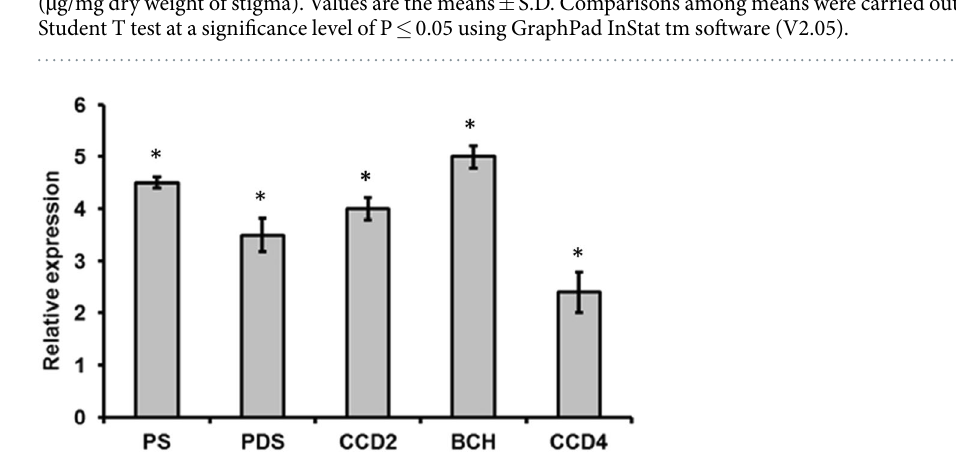
Figure 4. Effect of endophyte (CS10E4) on expression of genes involved in apocarotenoid biosynthesis. Transcript abundance of phytoene synthase ( PS) , phytoene desaturase (PDS) , betacarotene hydroxylase ( BCH) , carotenoid cleavage dioxygenase 2 (CCD2) , carotenoid cleavage dioxygenase 4 ( CCD4) was analyzed. Data are shown as relative expression levels of endophyte treated plants (Endo + ) in comparison to the endophyte free control (Endo − ) plants. 18 S was used as the internal reference gene. Data are means ± SD from three biological replicates. * Represents significance at P ≤ 0.05 using GraphPad InStat tm software